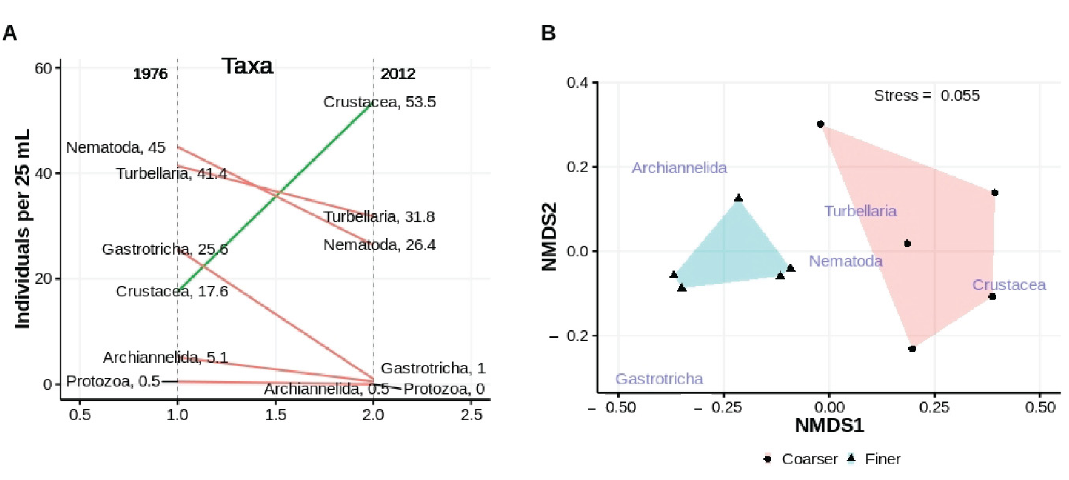
Figure 11. Univariate ( A ) and multivariate ( B ) comparisons of mean taxon abundances collected in low intertidal, surface finer and coarser sediment samples from ISP in 2012; non-metric scales serve to ease visual estimation of dissimilarity distances but are not associated with any specific units. Table 5. Mean ( ± 1 SE) density (# individuals per 25 mL) of each major taxon found in visually distinct finer and coarser surface sediments from the lower intertidal of EI. Probabilities derive from separate, Mann–Whitney comparisons testing the null hypothesis of no di ff erence in faunal abundances between finer and coarser sediments. n = 5 for each sediment type. Significant results ( p < 0.05) are in